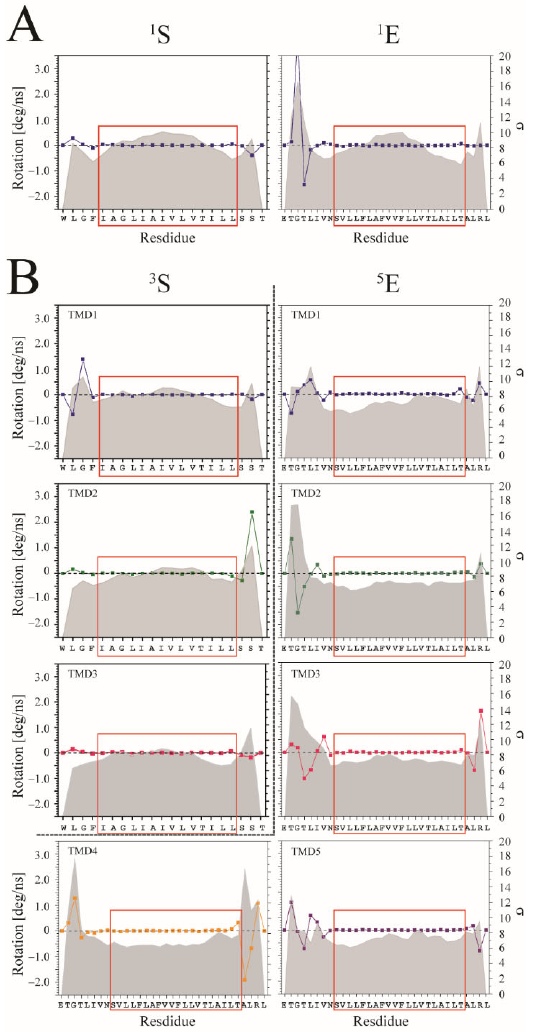
Figure 5. Averaged degree of rotation of the C α atoms per time step (ns) during the MD simulation for each of the residues of ( A ) the experimental monomeric peptides S and E, as well as ( B ) for their individual TMDs when they are simulated in their respective experimental oligomeric states. The standard deviation (STD) is shown as a grey line. The values are calculated from simulations of the experimental structures. The red boxes mark the amino acids used for calculating the curvature from the respective values of the STD. The superscript indicates the oligomerization state of the protein.